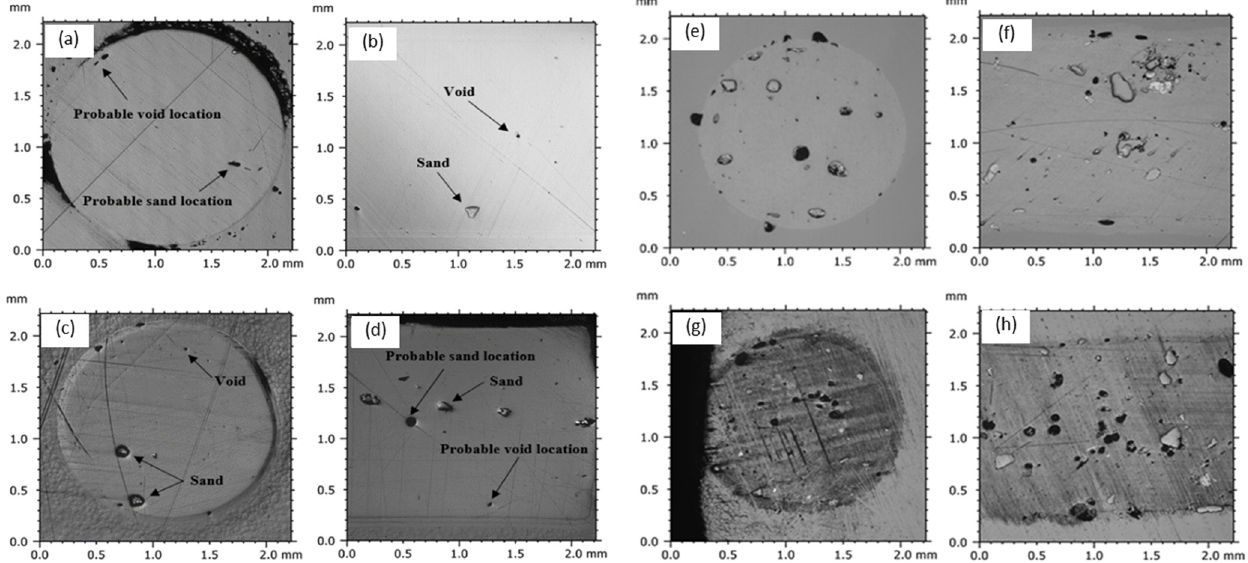
Figure 7. Microscopy images showing the dispersion of sand particles along the transverse and longitudinal filament directions. Images ( a , b ) represent the transverse and longitudinal directions of the 0.5 wt% sand reinforced filaments. Similarly, ( c , d ), ( e , f ), ( g , h ) correspond to the 1.0, 10, and 15 wt% sand, respectively. Horizontal lines are added to highlight the filament boundaries.